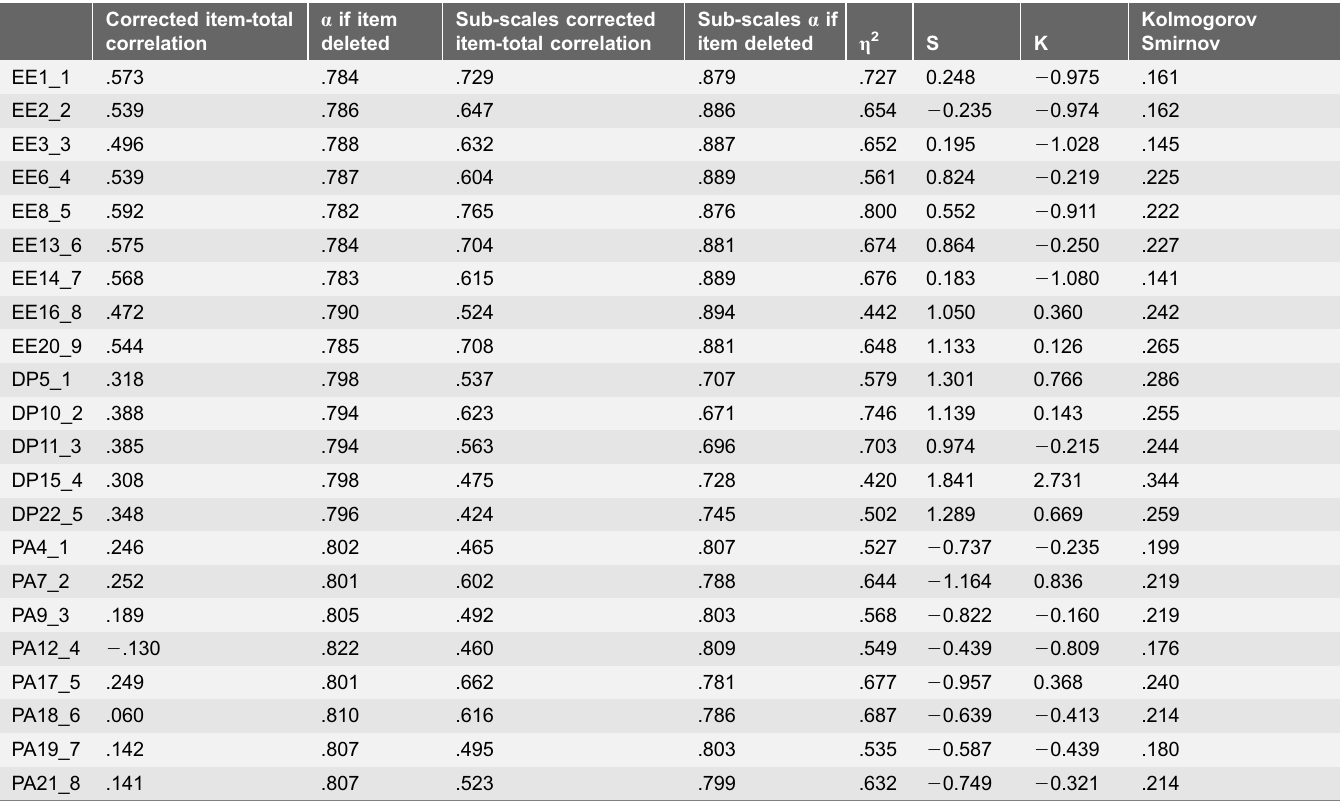
Table 3. MBI_HSS item homogeneity, discrimination, and distributional form. Corrected item-total